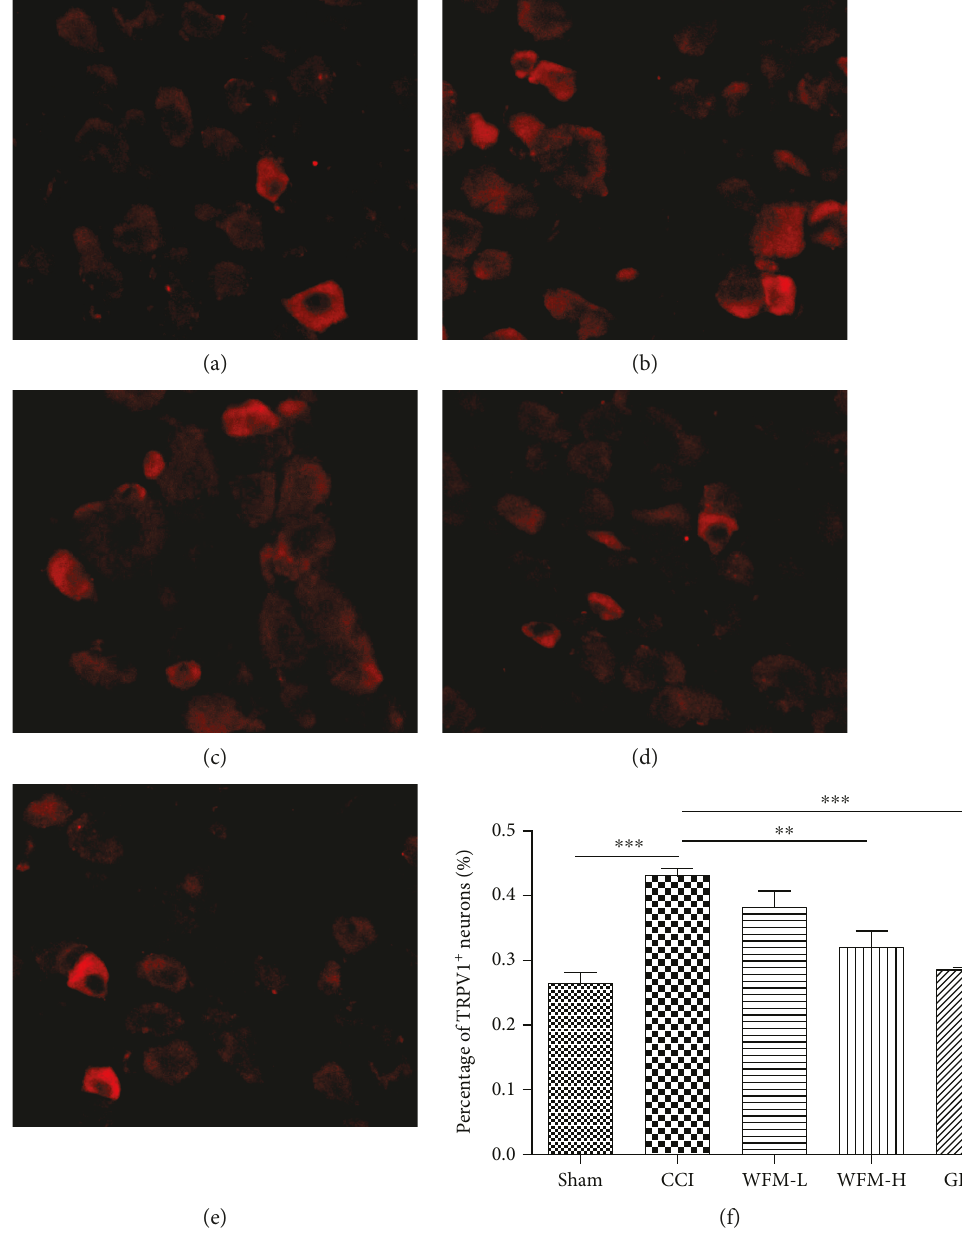
Figure 4: TRPV1 + neuron is increased in CCI model and can be restored by WFM treatment. Histochemistry staining of DRG from CCI model and WFM treatment groups. (a, b) The proportion of TRPV1 + population is increased in CCI model. (c, d) The fraction TRPV1 + neuron in DRG is signi fi cantly decreased after WFM treatment. (e) The fraction TRPV1 + neuron in DRG is signi fi cantly decreased after GBPT treatment. (f) Data are presented as mean ± SEM, ∗ p < 0 05 , ∗∗ p < 0 01 , ∗∗∗ p < 0 001 . Scale bar: 50 μ